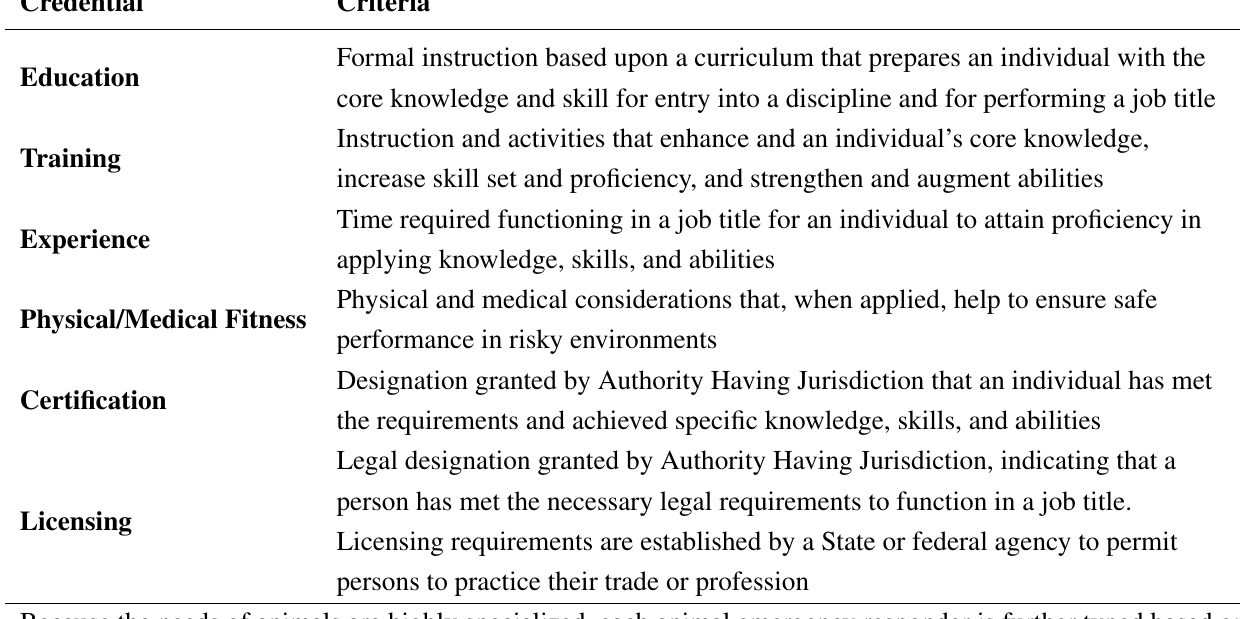
Table 1. Criteria used to credential Animal Emergency Responders (AER)